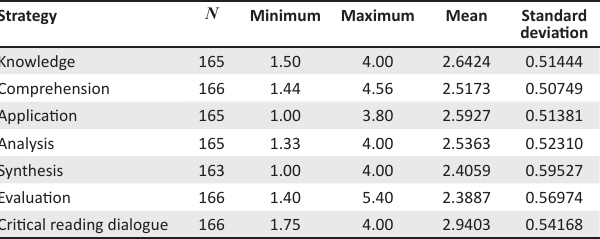
TABLE 2: Learners’ self-perceived and self-rated ability to use critical reading strategies based on the questionnaire instrument. Strategy N Minimum Maximum Mean Standard